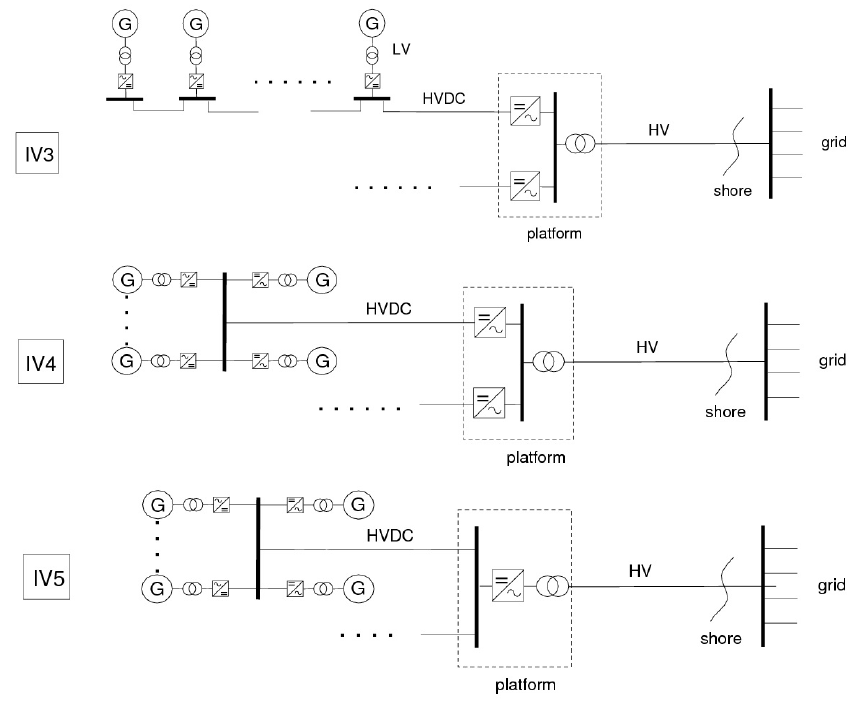
Figure 5 . Individual variable speed with HVDC system.